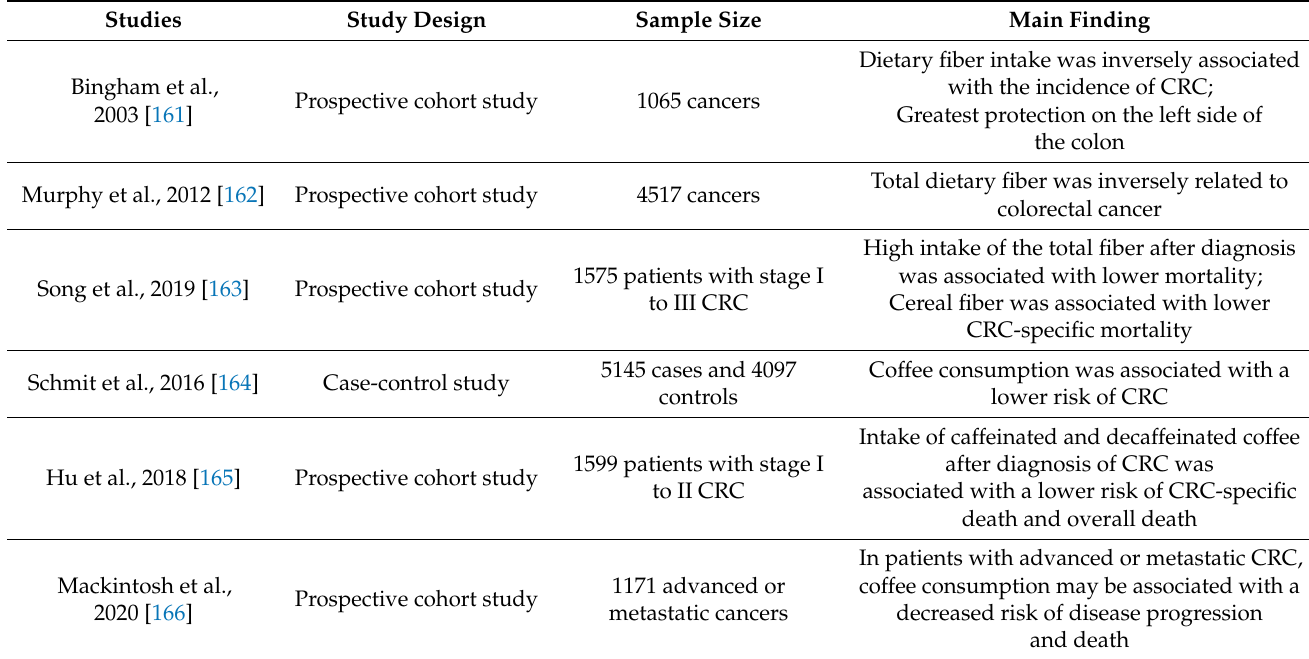
Table 1. Key Clinical Diet Intervention Associated with Reduced Risk and Improved Survival of